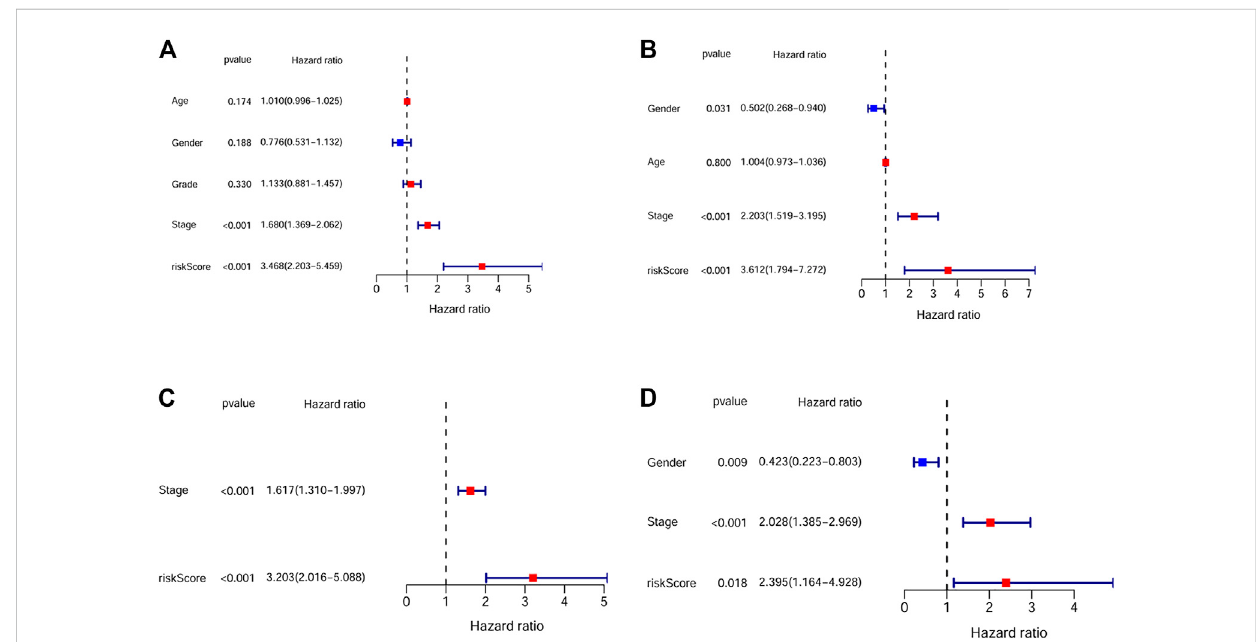
FIGURE 4 Theindependentprognosticvalueoftheriskscore. (A) UnivariatecoxregressionanalysisfortheTCGAdataset. (B) Univariatecoxregressionanalysis for the ICGC dataset. (C) Multivariate cox regression analysis for the TCGA dataset. (D) Multivariate cox regression analysis for the ICGC dataset.